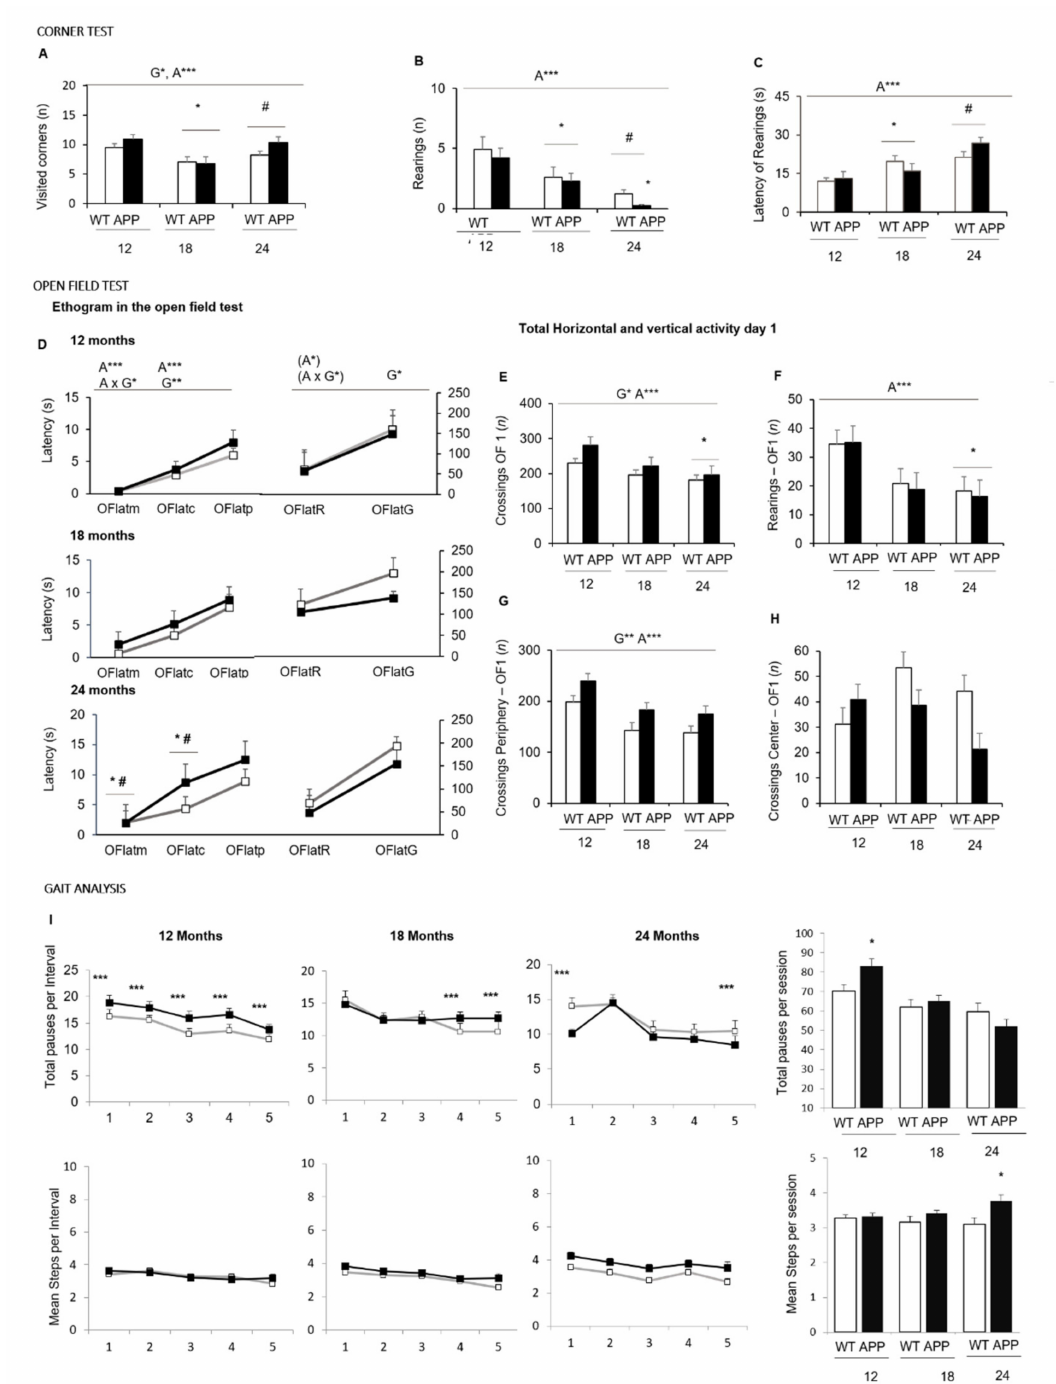
Figure 2. NPS-like behaviors and gait analysis in the corner and open-field test—Effect of age and AD-genotype on the neophobia and exploratory activity elicited in a new home cage (corner test, ( A – C )) and the open-field test ( D – I ) at 12, 18, and 24 months of age. Data are expressed by Mean ± SEM. WT: wildtype mice; APP: APP23 mice. Corner test: Visited corners ( A ), number ( B ), and latency of rearings ( C ). Open field test: Ethogram, the temporal sequence of behavioral events in the open field test, Variables: OFlatm, latency of the first movement; OFlatc, latency to leave the central area; OFlatp, latency to enter into the periphery; OFlatR, latency of the first rearing; OFlatG, latencies of the first grooming ( D ). Total horizontal ( E ) and vertical ( F ) activity in the open-field test. Total horizontal activity in the periphery ( G ) and the central area ( H ). Gait analysis: Total number of pauses ( I ) and mean number of crossings in each time interval and in the total time of the open field test. Analysis of variance 2 × 3: Effects of genotype (G), Age (A) * p < 0.05, ** p < 0.01, *** p < 0.001. Post-hoc analysis: * p < 0.05 vs. 12 months of age, # p < 0.05, vs. 18 months of age; * p < 0.05 vs. the corresponding WT control